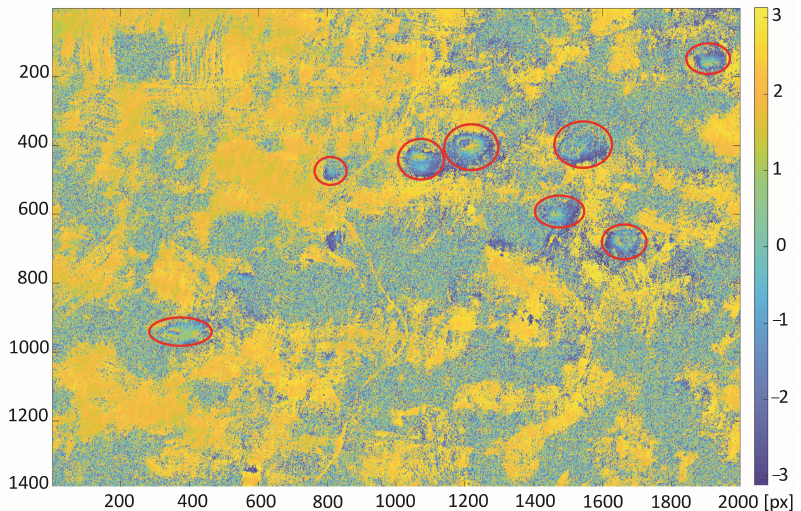
Figure 9. Differential interferogram of the second area with marked subsidence areas (red ellipses) calculated for the study area from satellite images taken on the 10th and 22nd of October